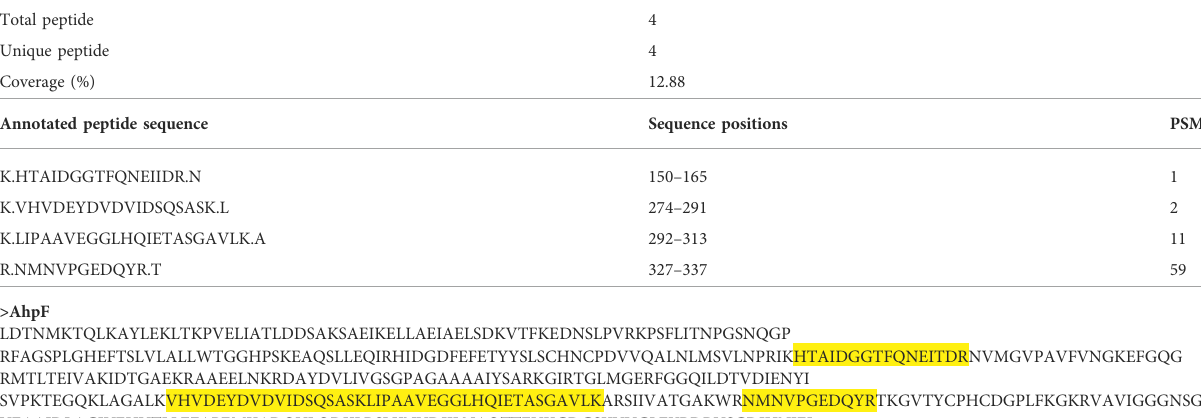
TABLE 2Identi fi cation ofAhpFproteinfrom proteomicsanalysis of C7fractionfrom anionexchange puri fi cation of3-LSR. Thesequence highlighted in yellow shows the coverage of the total protein sequences for AhpF. PSM represents the total peptide to spectrum match. Total